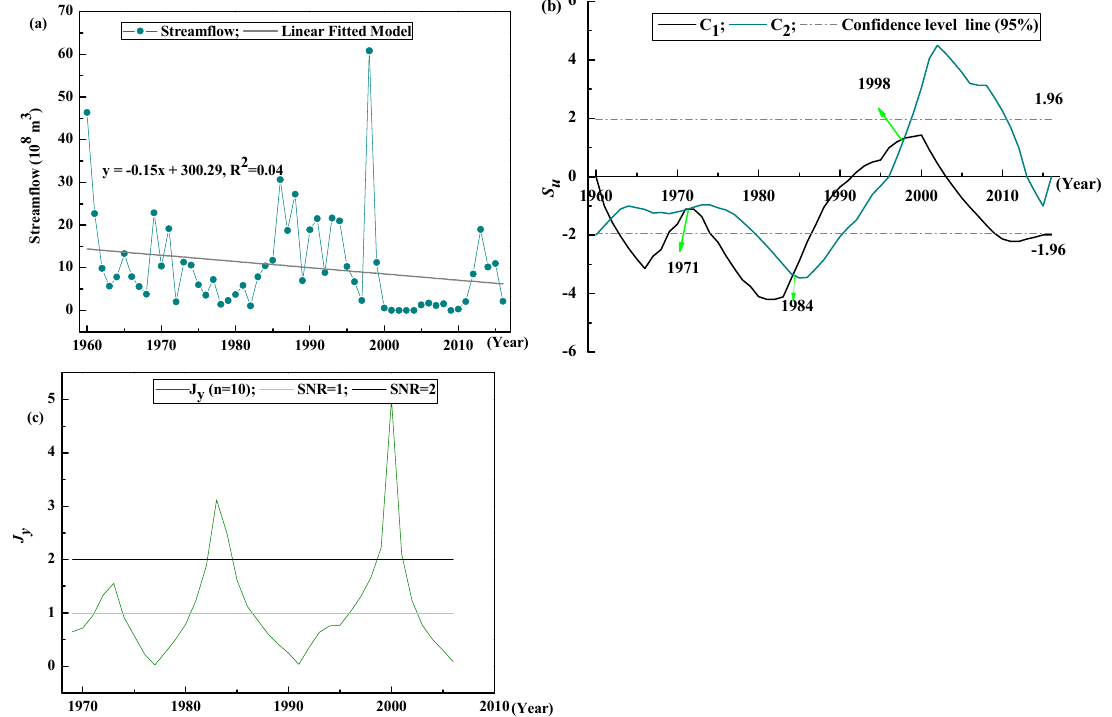
Figure 4. Temporal trends ( a ) and abrupt changes ( b, c ) in streamflow for the Taoer River. The timing of abrupt changes detected by Mann-Kendall method ( b ) and Yamamoto method ( c ) also showed in Figure 4b. S u is the M–K rank statistics, C 1 and C 2 are two curves of the Mann-Kendall rank statistics. The confidence level (95%) is also shown in the figure. The green arrow pointed the intersection point of the C 1 and C 2 to show the abrupt changes. For the Yamamoto method, J y is the signal-to-noise ratio; SNR = 1, at 95% significance level; SNR = 2, at 99% confidence level. Table 3. The ecological water requirement for minimum (E wm ), basic (E wb ), and suitable (E ws ) environmental flow (e-flow) during di ff erent hydrological